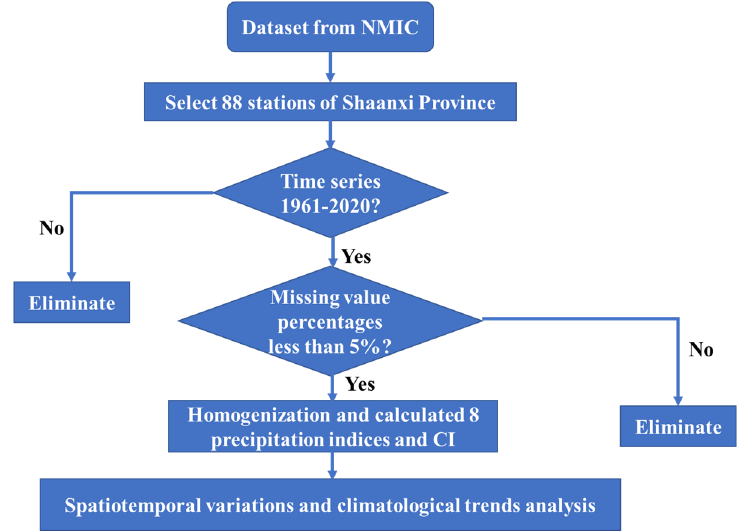
Figure 1. Flowchart of the methodology.